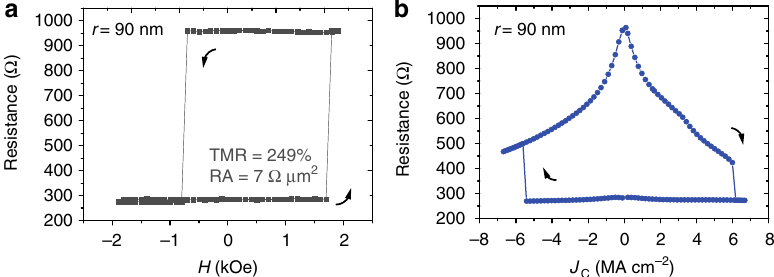
Fig. 2 Magnetoresistance and STT measurements for p-MTJ ( r = 90 nm) at room temperature. a Magnetoresistance as a function of out-of-plane magnetic fi eld and b STT switching measured by DC current sweep. Arrows show the perpendicular magnetization transitions from AP to P states or the opposite